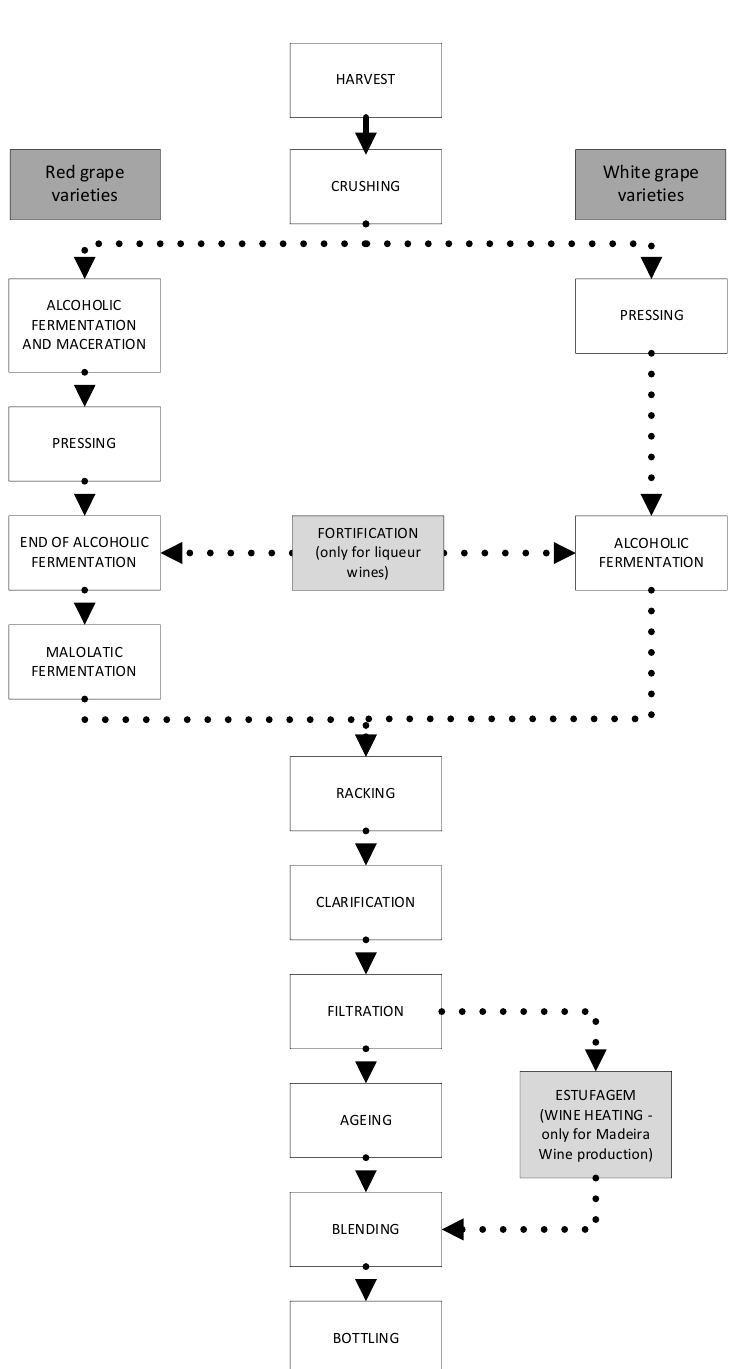
Figure 3. Schematics of the main unit operations related to the winemaking processes (adapted from Gil-Serna et al. [ 38 ]).